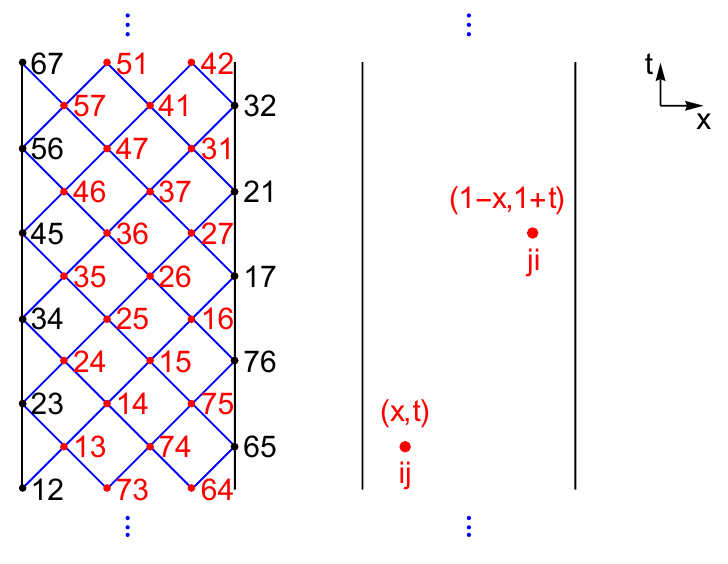
Figure 2 . The infinite array of planar variables.